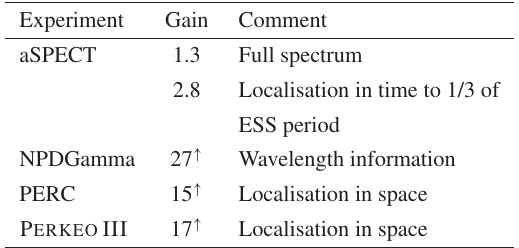
Figure 4. Left: Simulated divergence distributions in horizontal ( x ) and vertical ( y ) direction at the guide exit for neutrons between 2 ˚A and 8 ˚A (weighted with their capture cross-section and integrated over the other direction and the guide exit area). Right: Simulated capture flux density spectrum averaged over the guide exit. Table 3. Simulated gain in counting rate for the reference experiments at ANNI (ESS at 5 MW) relative to the respective presently used facility. Gains marked by ↑ refer to polarised beams. Details on the determination of the gain factors are given in appendix